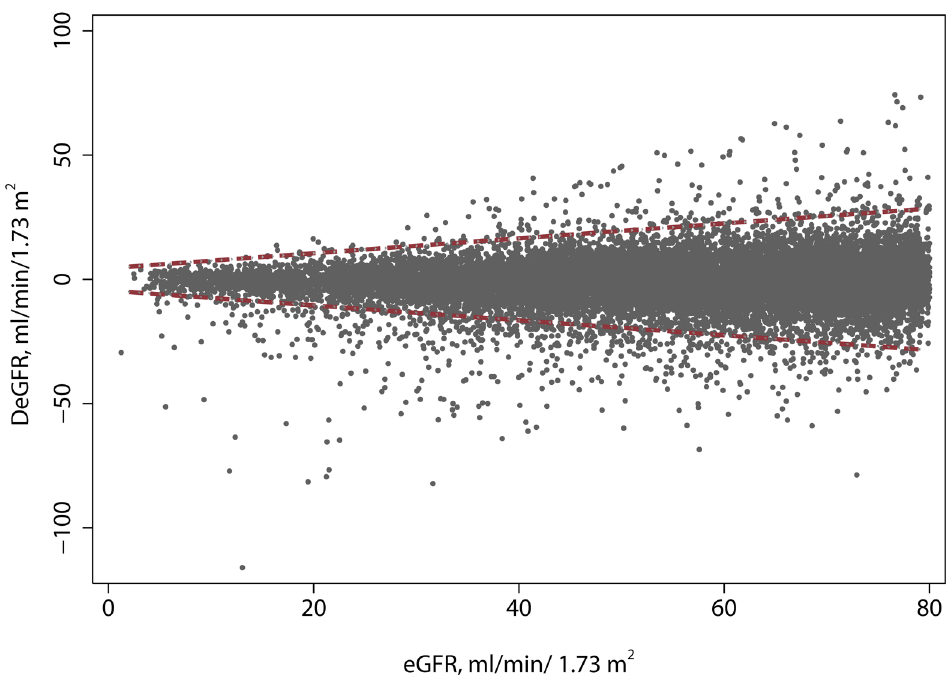
Fig 5. Biological Variability of eGFR. Each point represents the difference between consecutive eGFR measurements in one patient. The dashed line represents the estimated limit of biological deviation (95% confidence